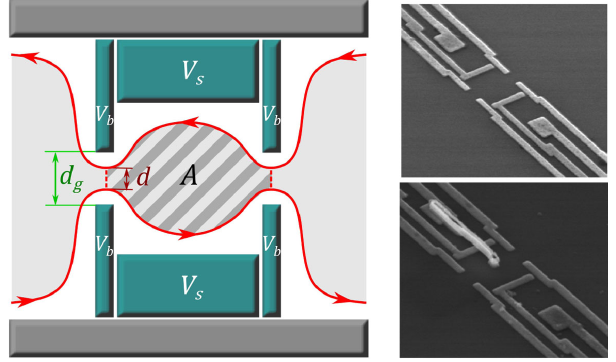
FIG. 2. Schematic and electron-micrograph images of interfer- ence devices. The interferometer is defined by surface gates operated at voltages V and V that deplete the electron b s population below them. Currents propagate along the edges separating the incompressible QH liquid (shaded) and the depleted regions; contacts diffused into the heterostructure away from the device are used to measure resistance across the device longitudinally R and in Hall configuration across the device R . L D Edge current can backscatter at one of the two constrictions resulting in interference of the two paths. The area between the two paths — the active area A of the interferometer — is indicated by stripes; the filling factor within the active area is the same as in the shaded bulk regions on either side. Device images show one device with no structure inside area A (top, device type (a) and another one with a top gate central dot (device type b). In each device, the lithographic separation d of gates defining the g constrictions is approximately 1 μ m. The actual tunneling dis- tance between the edge currents d is controlled by the gate voltage V b